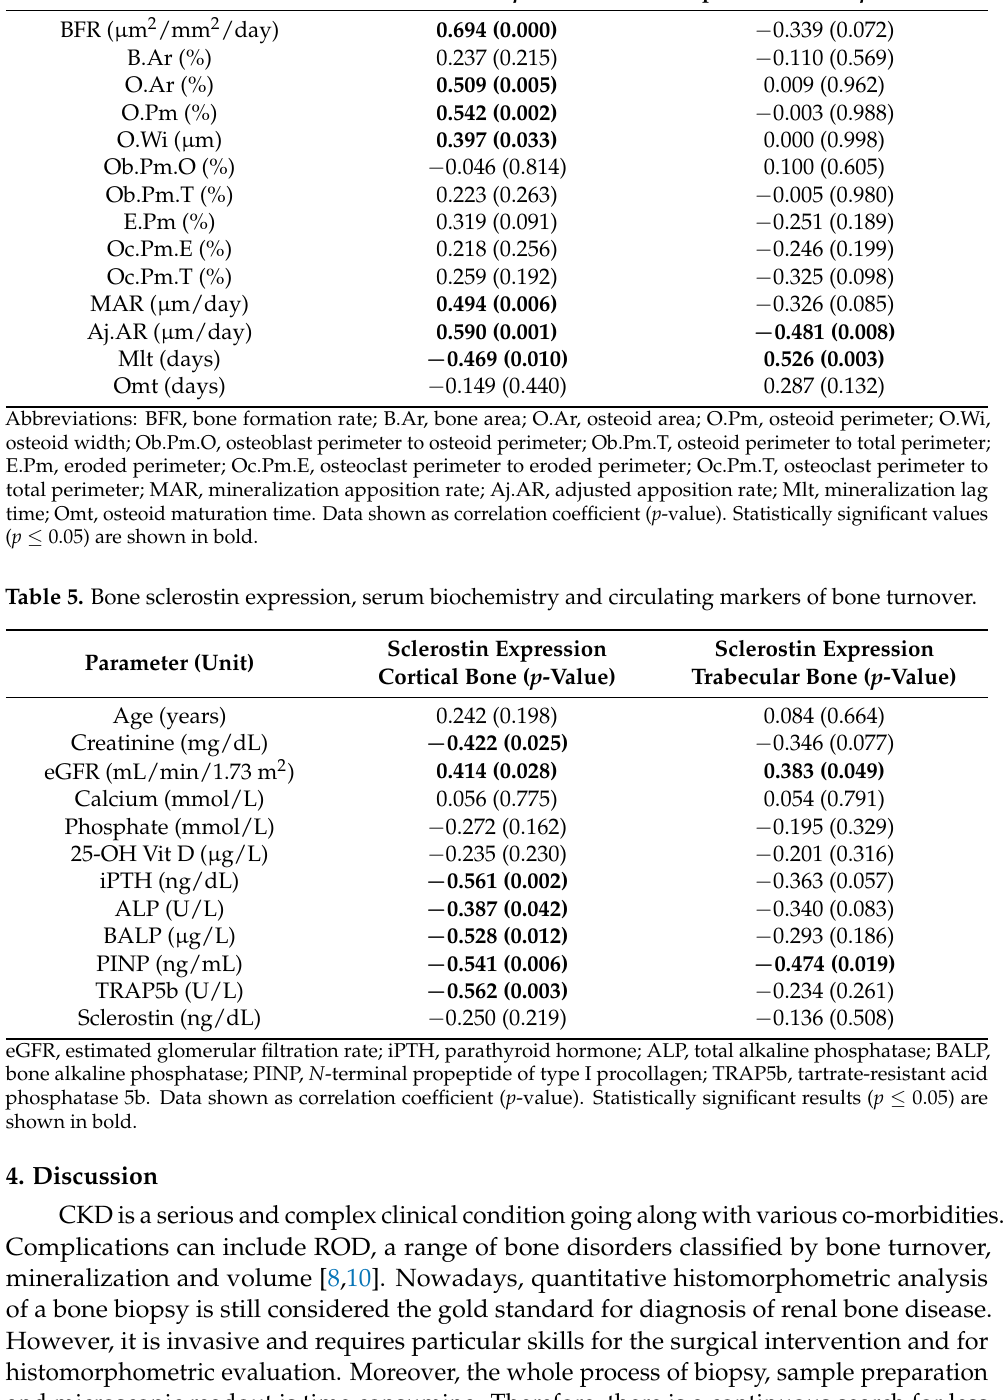
Table 4. Correlations between bone histomorphometric parameters in trabecular bone and cell counts. Parameter (Unit)